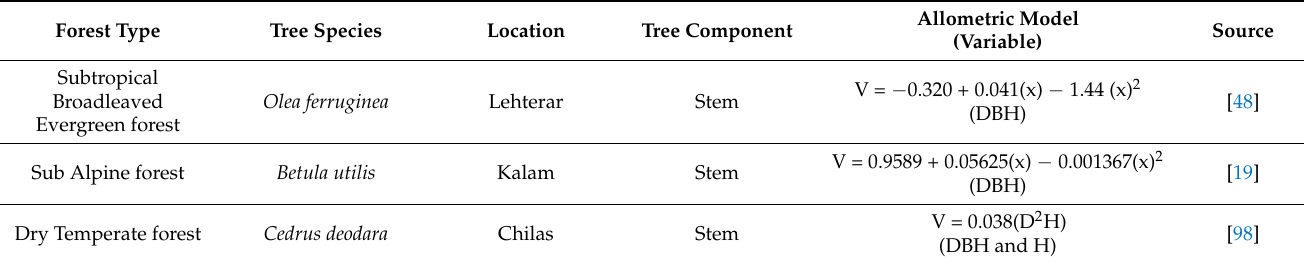
Table 5. Volume allometric models for forest stand volume